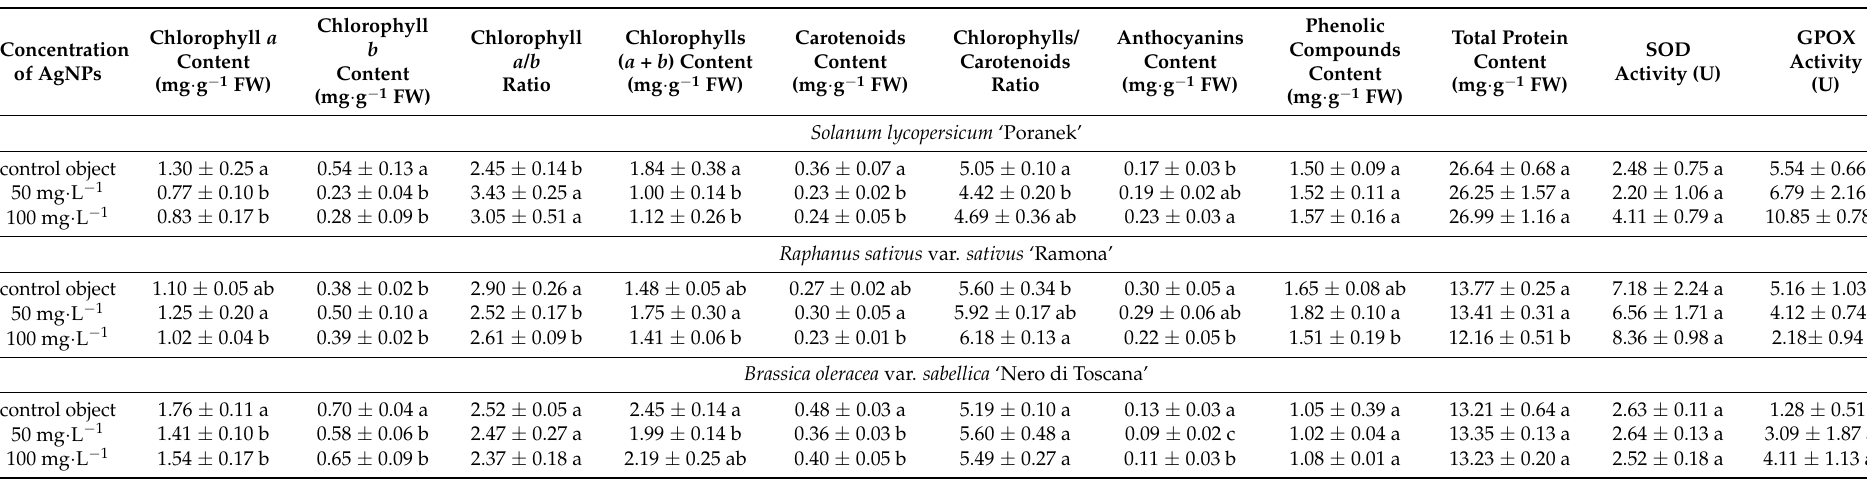
1 Values represent means ± standard deviation. Means in columns for each tested vegetable plant species followed by the same letter do not differ significantly at p ≤ 0.05 (Tukey’s